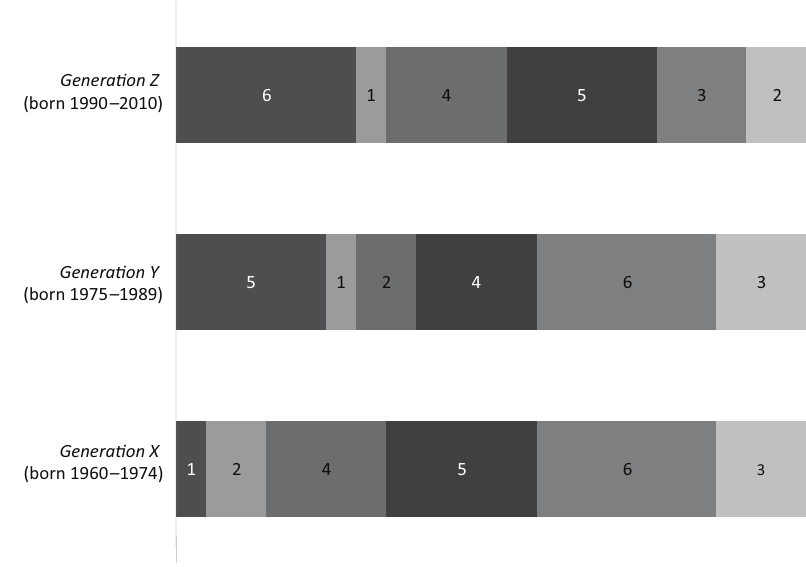
fig. 5. Ranking of type of social network associates, N =